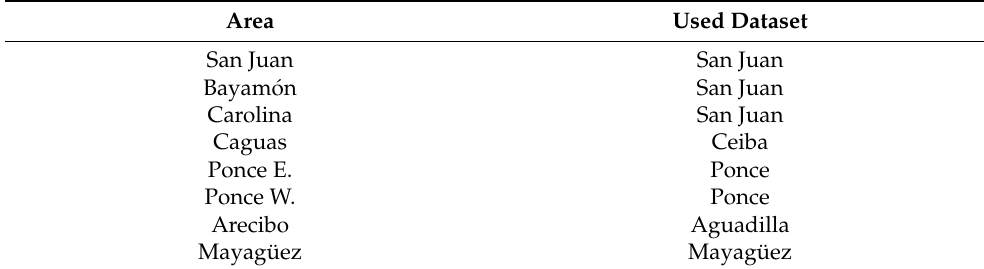
Table 7. Datasets from NREL used for each